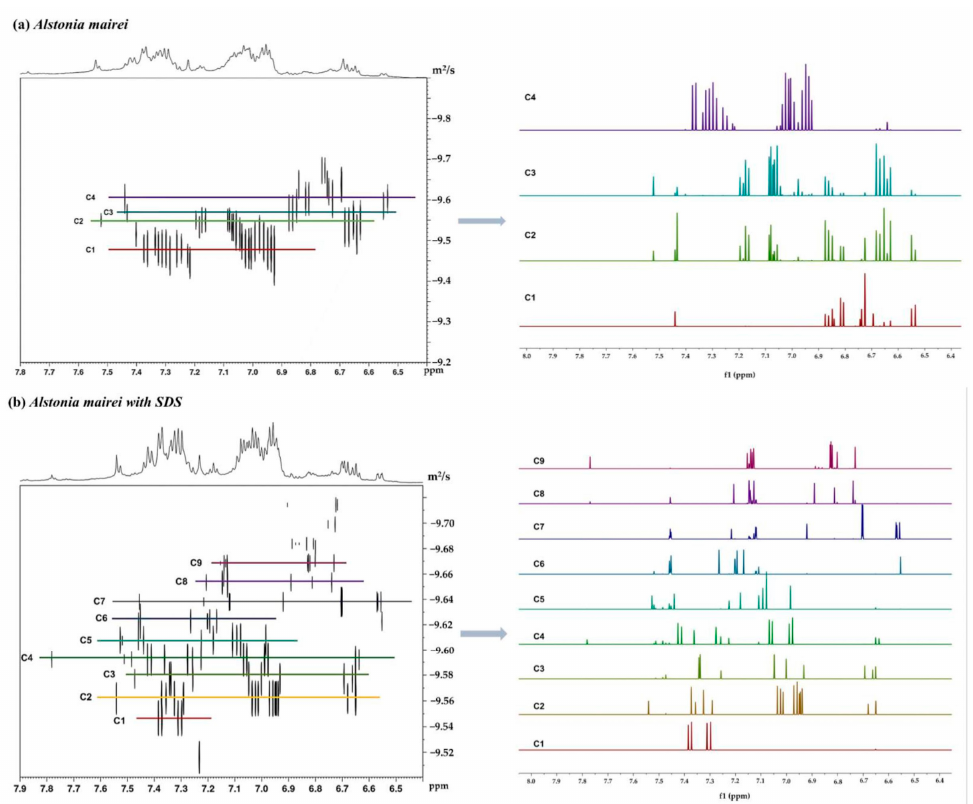
Figure 8. DOSY spectra of a mixture of the real total alkaloid extract (20 mg) before ( a , upper) and after ( b , lower) the addition of SDS (10 mg) in DMSO- d 6 (600 μ L). Experimental temperature was 298 K.